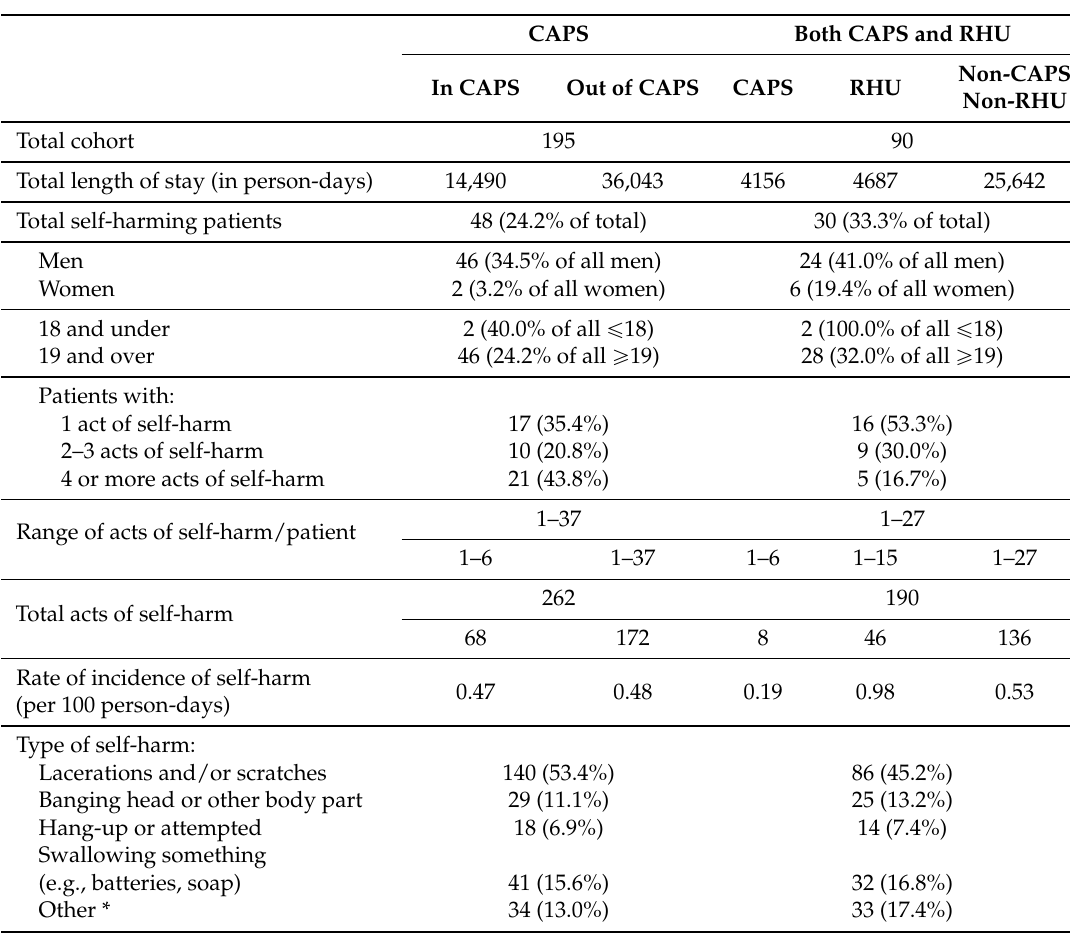
Table 3. Self-Harm. CAPS Both CAPS and